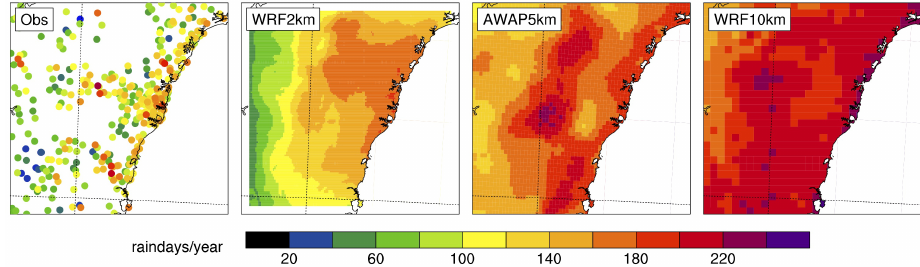
Fig. 2. Annual mean number of rain days over the period 1990–2009 for stations, the WRF simulation at 2km resolution, the AWAP data set and the intermediate WRF domain at 10km resolution used to provide the boundary conditions.